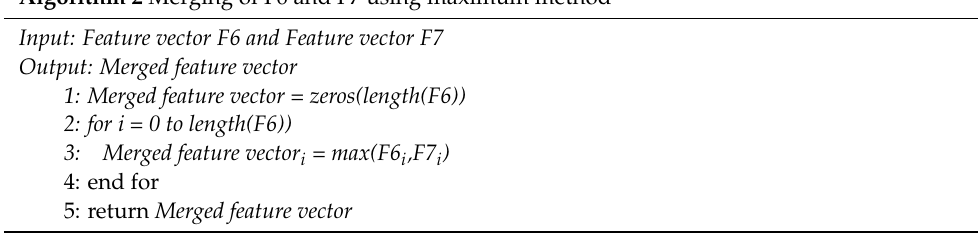
Algorithm 2 Merging of F6 and F7 using maximum method